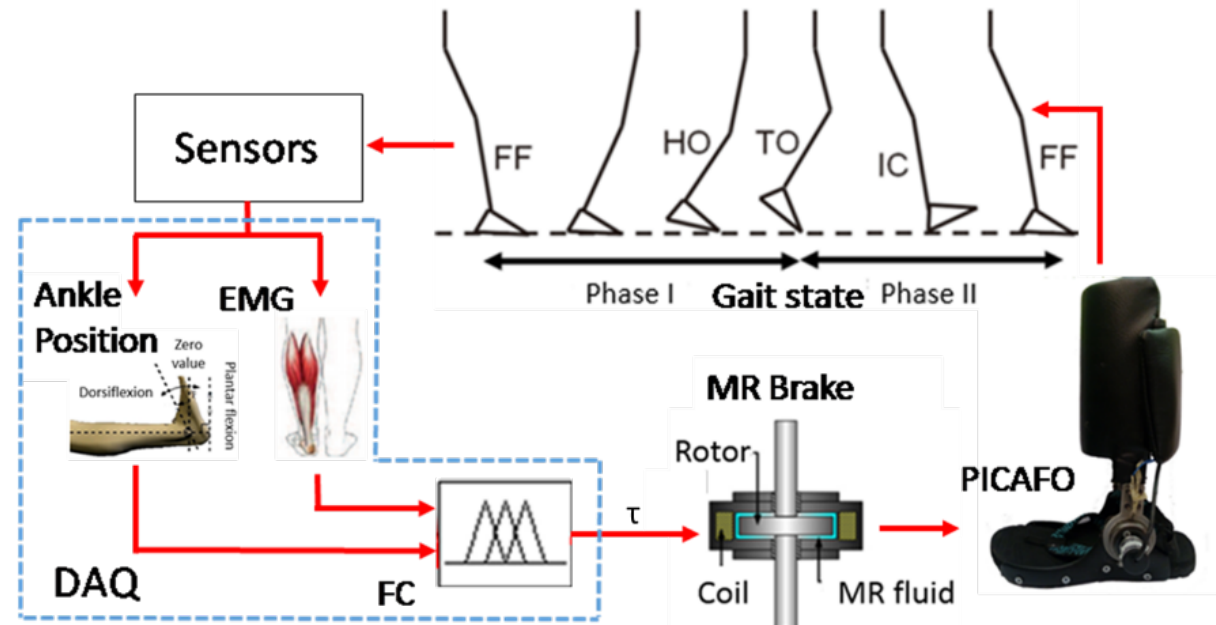
Figure 1: Overview of the PICAFO control system in the previous work